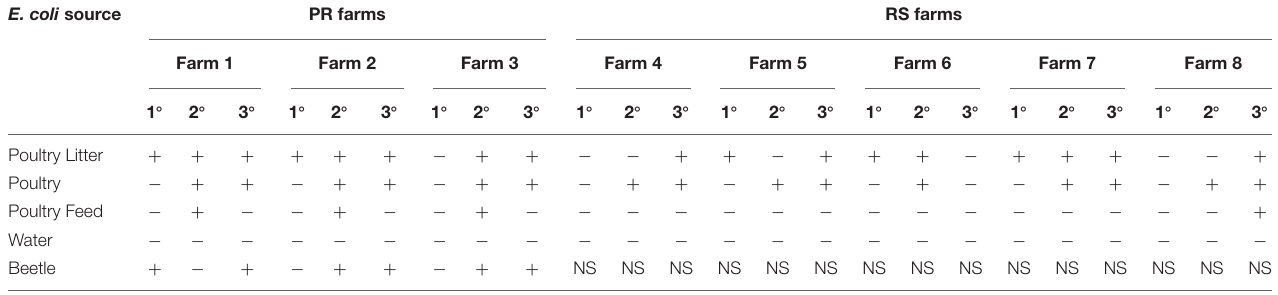
TABLE 1 | Detection of ESBL-producing E. coli isolated in MC/CTX agar from farms in PR and RS states. E. coli source